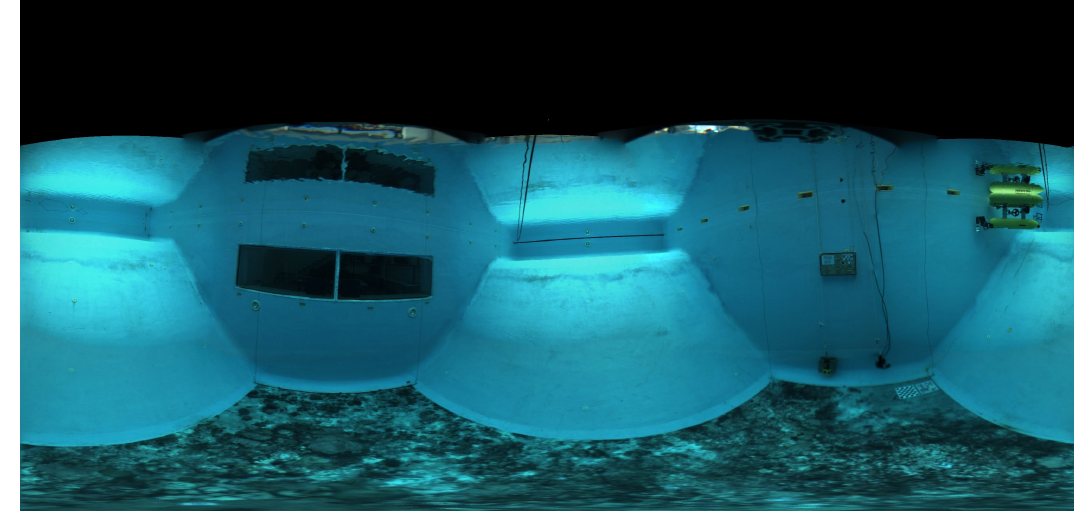
Figure 20. Equirectangular panorama of the CIRS water tank projected at a distance of 4 m with gradient